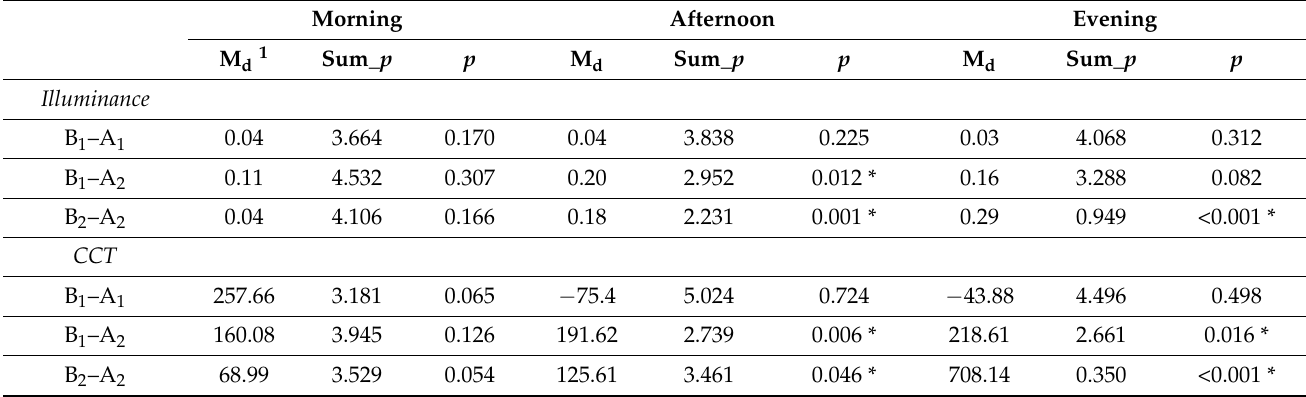
Table 6. Results of the randomization tests for morning, afternoon, and evening.